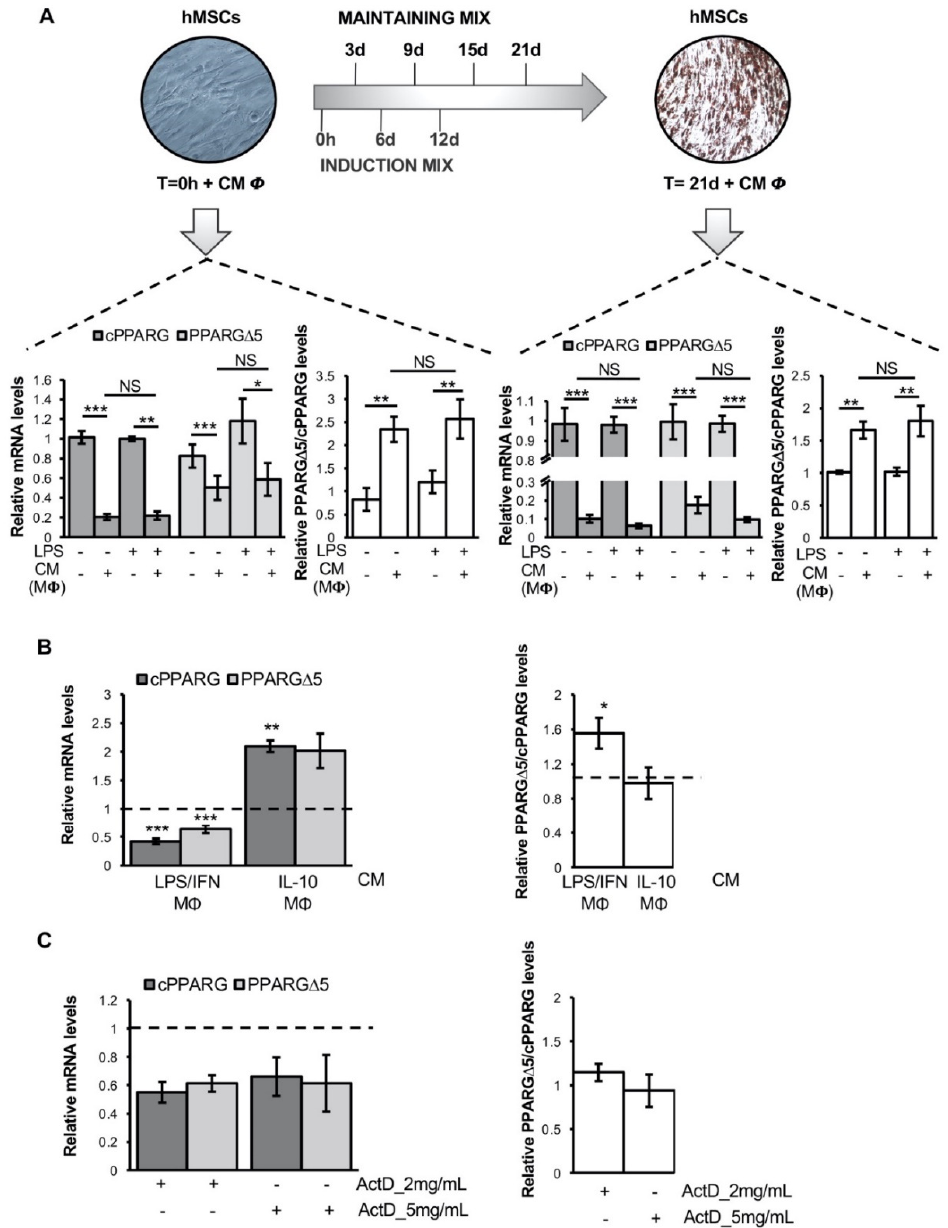
Figure 2. Human pro-inflammatory macrophages secretome perturbs PPARG splicing in human mesenchymal stem cells: ( A ) Representative images (upper panel) of human mesenchymal stem cells (hMSCs) at an undifferentiated stage (i.e., 0 h) and completely differentiated in mature adipocytes (i.e., 21 days upon differentiation induction) by using an induction and a maintaining mixes as reported on the timeline. hMSCs at 0 h and 21 d after adipocyte differentiation were treated for 24 h with conditioned medium (CM) of THP-1 macrophages (M Φ ) activated and not with LPS. Below are reported relative mRNA levels (qPCR) of cPPARG, PPARG ∆ 5 and the PPARG ∆ 5/cPPARG ratio in hMSCs at 0 h (left panel) and in hMSCs at 21 d (right panel) treated with CM of M Φ . hMSCs at 0 h or at 21 d treated with control medium supplemented or not with LPS were used as reference samples and PPIA as reference gene. Data are reported as mean ± SEM of at least three independent experiments. * p ≤ 0.05, ** p ≤ 0.01 and *** p ≤ 0.001. ( B ) Relative mRNA quantification (qPCR) of cPPARG, PPARG ∆ 5 (left panel) and the PPARG ∆ 5/cPPARG ratio (right panel) in hMSCs at